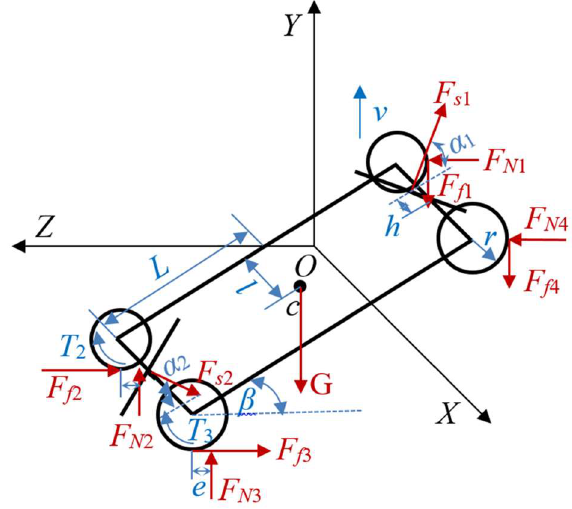
Figure 4. Dynamic analysis of DP-Climb internal transition. 2 L represents the length of the robot’s body, which is also the distance between the front and rear wheels, 2 l represents the left and right wheel distances, h represents the vertical distance between the rotor fixed platform and the body, r represents the wheel radius, and e / r represents the wheel rolling resistance coefficient. F s 1 and F s 2 represent the reverse thrust provided by the front and rear rotor units of the robot, respectively, F Ni (i = 1, 2, 3, 4) represents the positive pressures of each wheel, F fi represents the sliding friction force on each wheel, G represents the total gravity of the robot, τ is the driving torque of the driving wheels, which is [ T 2 T 3 ], and T 2 and T 3 are the driving torques of the left and right rear wheels, respectively. Simplifying the wheel model of the robot, the longitudinal adhesion coefficient of each wheel on the wall is µ i , and M fi represents the rolling resistance moment of each wheel. Since the value of e is very small, it can be neglected in the positive pressure analysis of each wheel. The resultant forces of DP-Climb along each coordinate axis of { XYZO } are: